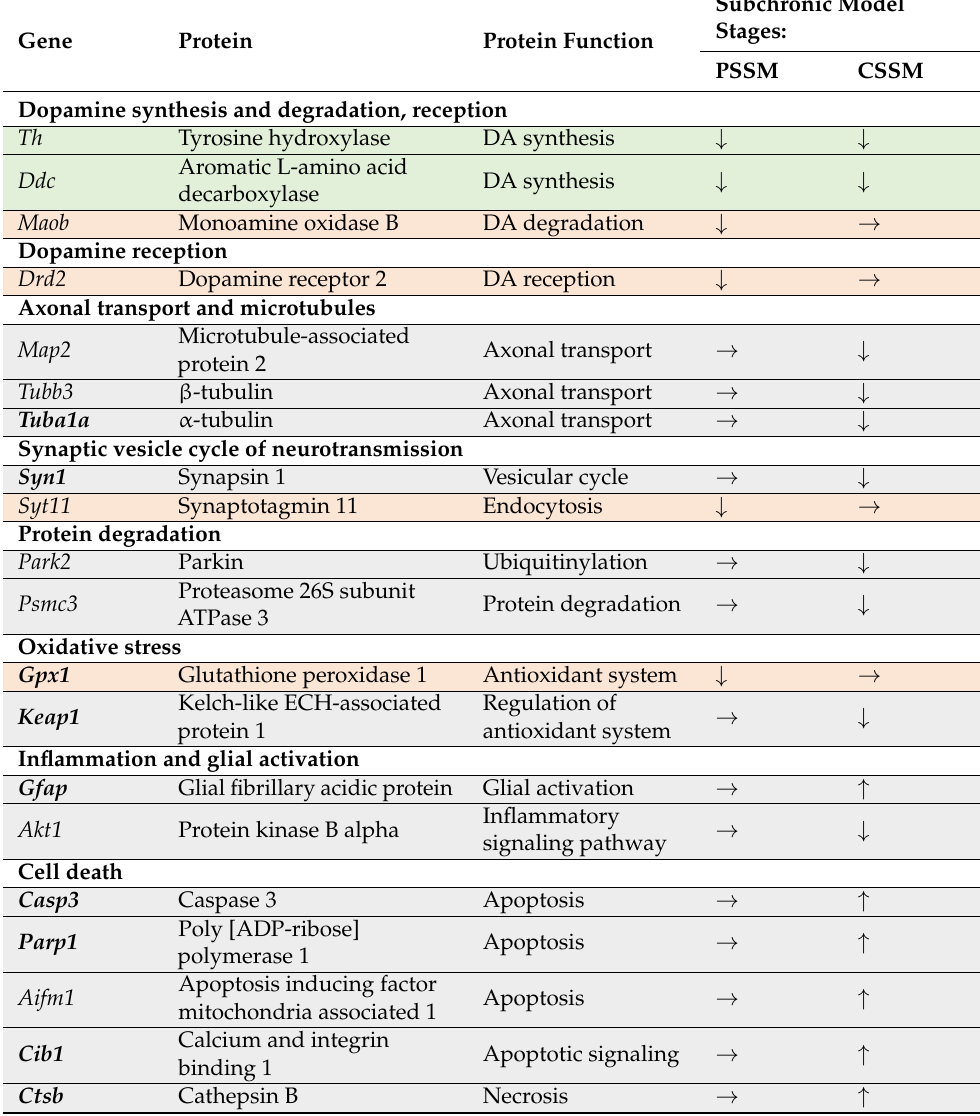
Table 4. Gene expression of enzymes of dopamine metabolism and reception as well as proteins involved in neurodegeneration in the substantia nigra in mice in preclinical (PSSM) and clinical (CSSM) models of Parkinson’s